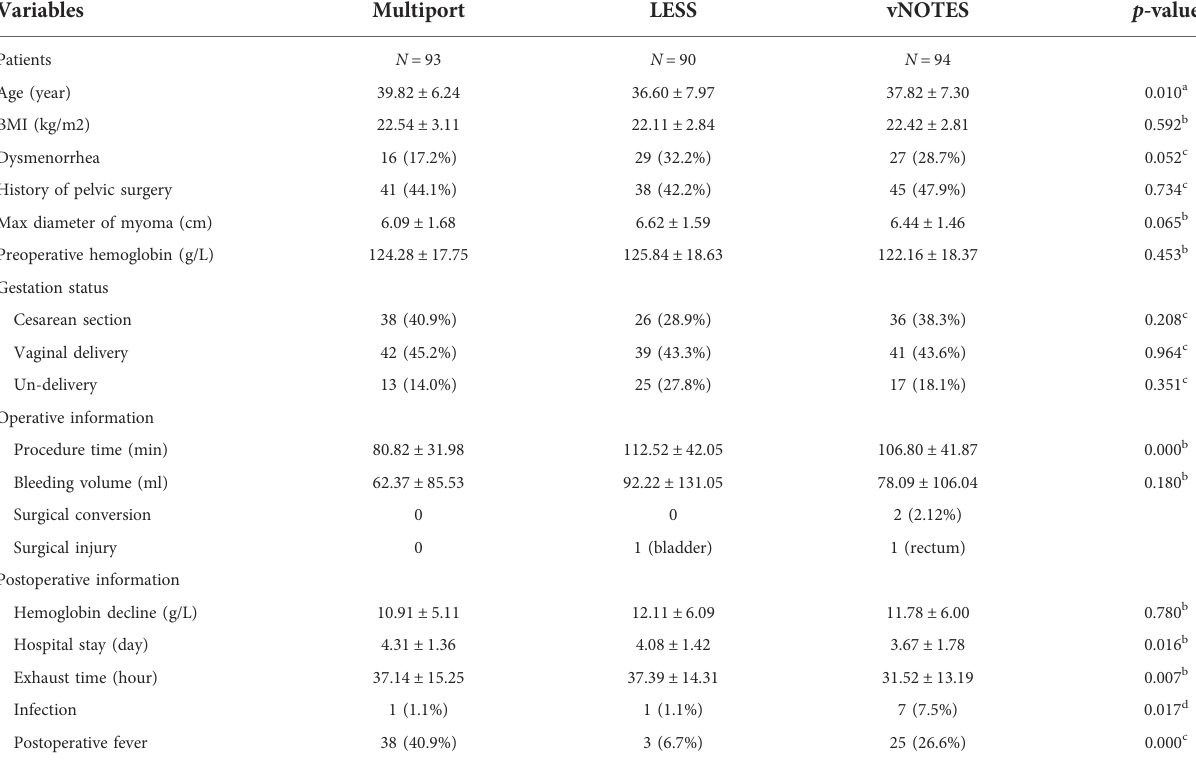
TABLE 2 Description of the patient characteristics by myomectomy